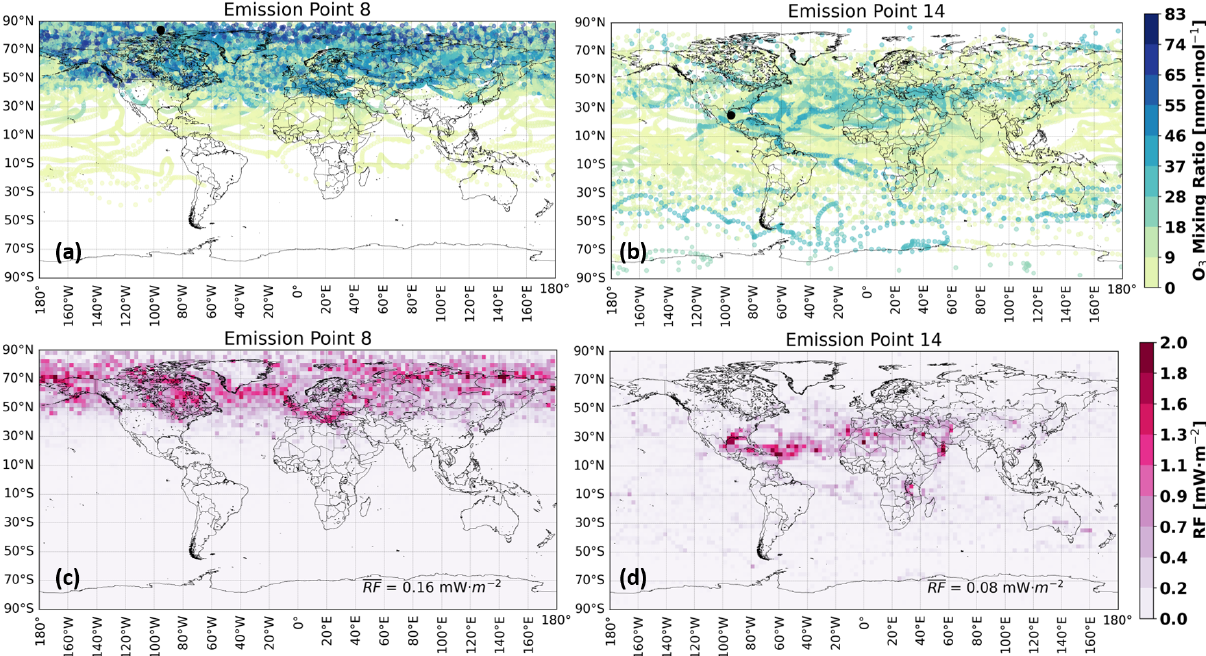
Figure 11. Horizontal profiles of mean O 3 disturbances in N. America in nanomoles per mole (nmolmol − 1 ) during July 2014 for (a) emis- sion point 8 and (b) emission point 14. The mean radiative forcing RF in milliwatts per square meter (mWm − 2 ) for (c) emission point 8 and (d) emission point 14. The black dots in (a) and (b) represent the emission starting points.